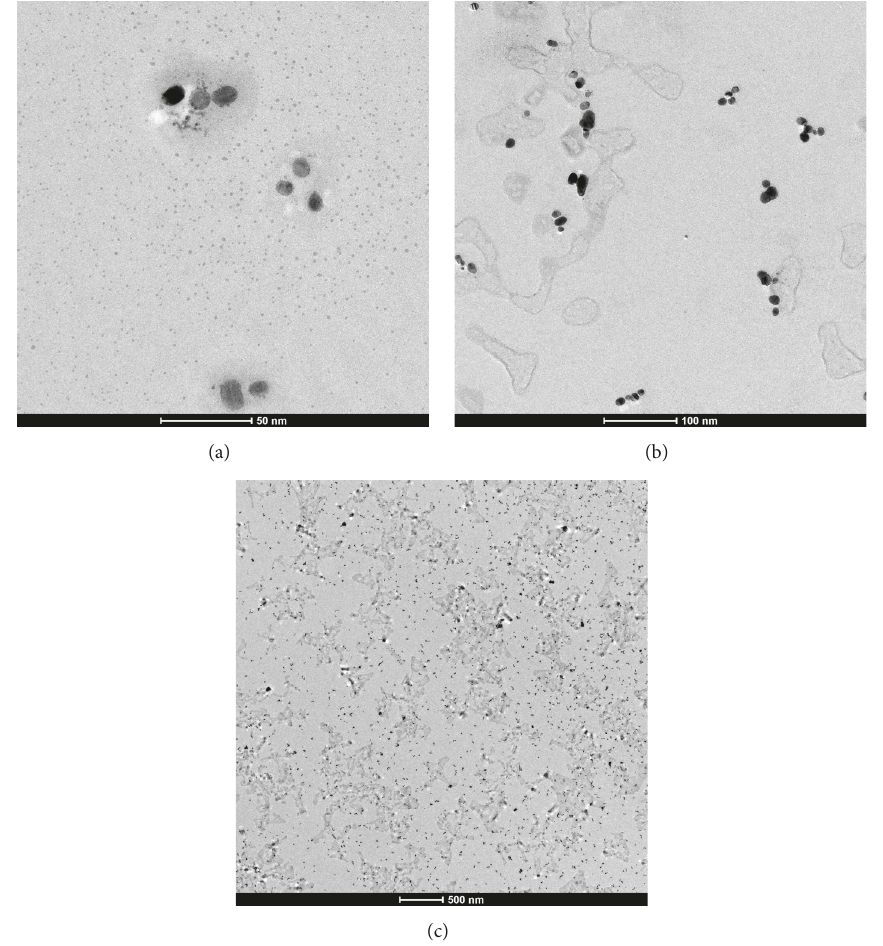
Figure 8: TEM image of nanosystem